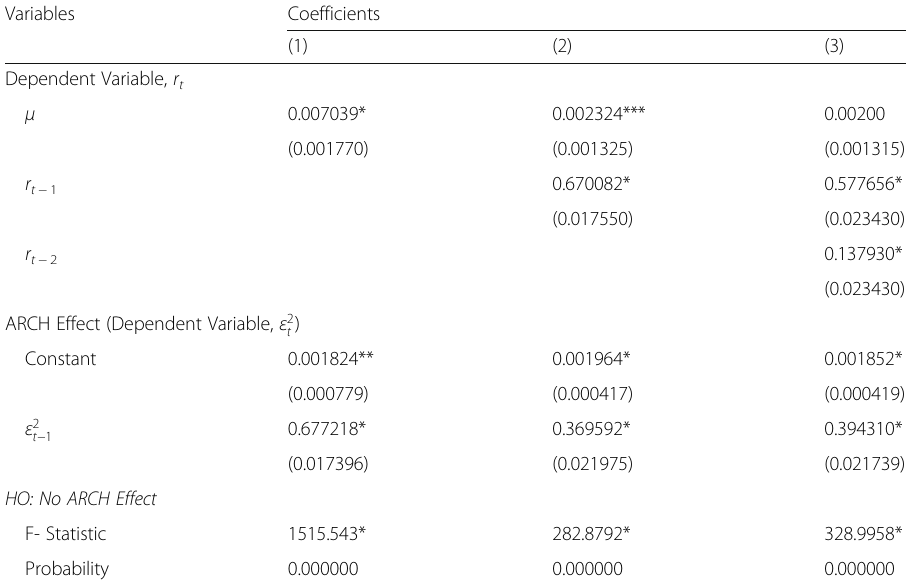
Table 1 Estimation of different conditional mean models and testing for ARCH effect